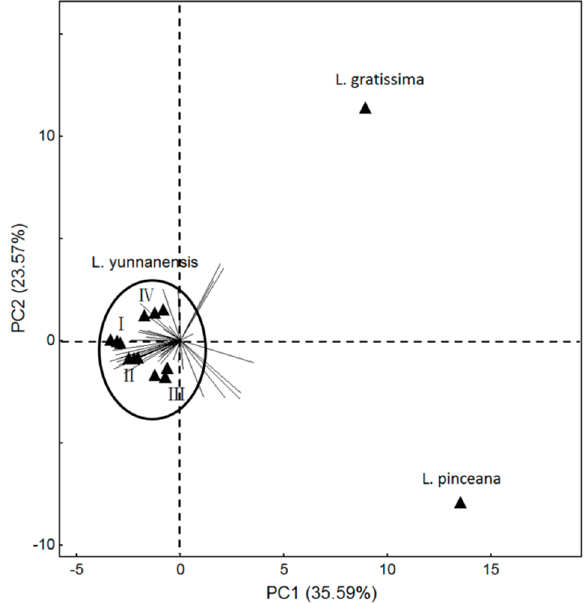
Figure 5. Principal component plots (PC1 vs. PC2 plots) for the volatiles of the full-flowering stage of L. gratissima , the full-flowering stage of L. pinceana , and the different flower stages of L. yunnanensis . (I) bud stage; (II) initial-flowering stage; (III) full-flowering stage; (IV) end-flower stage.